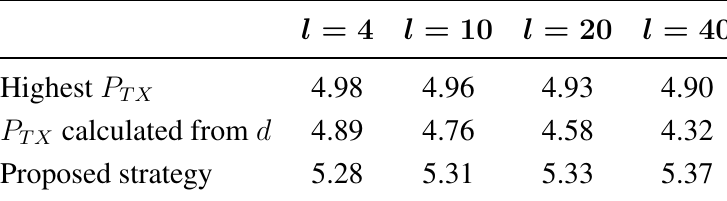
Table 4. Average number of received packets at the furthest